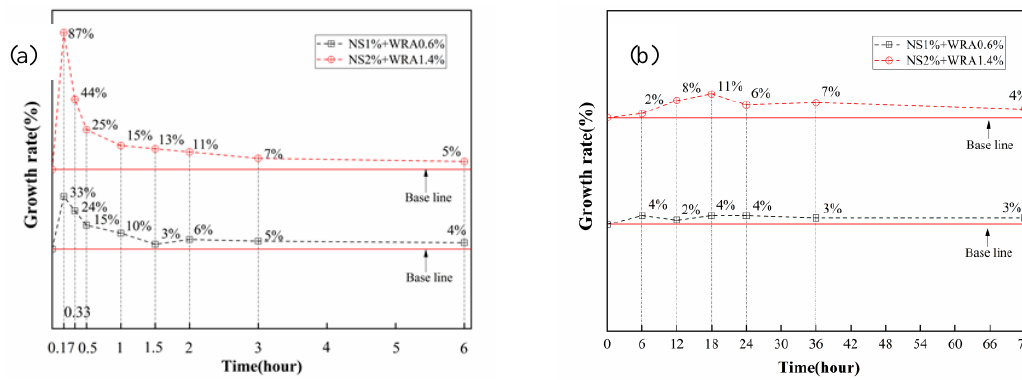
Figure 3. Growth rate of cumulative hydration heat: ( a ) HBSAC cement; ( b ) P·O 42.5 cement .